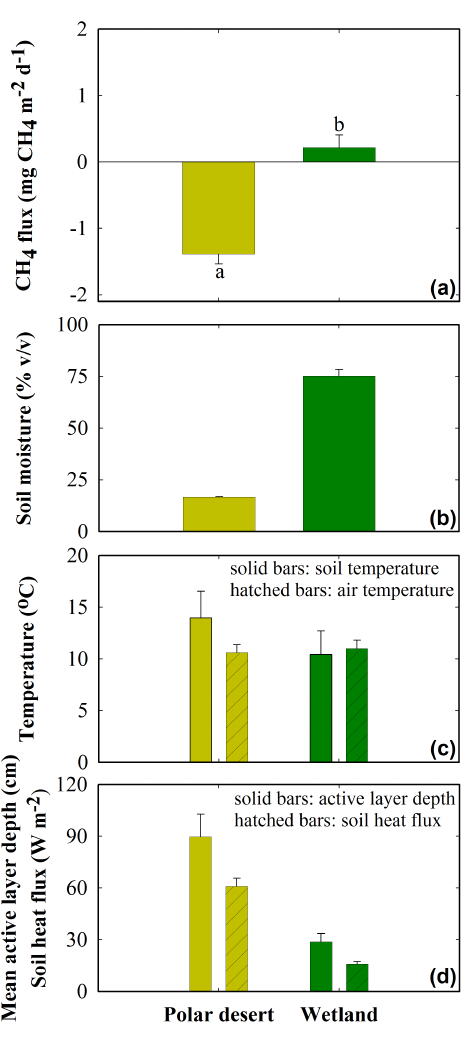
Figure 3. Comparison of 2010–2012 growing season mean CH 4 fluxes ( F CH ; ± 1SE) measured in chambers (a) and other environ- 4 mental variables (b–d) , paired by site. The sampling period repre- sented by each bar spans approximately late June to early August. Letters indicate if there were statistically significant differences of F CH between sites using a repeated-measures 4